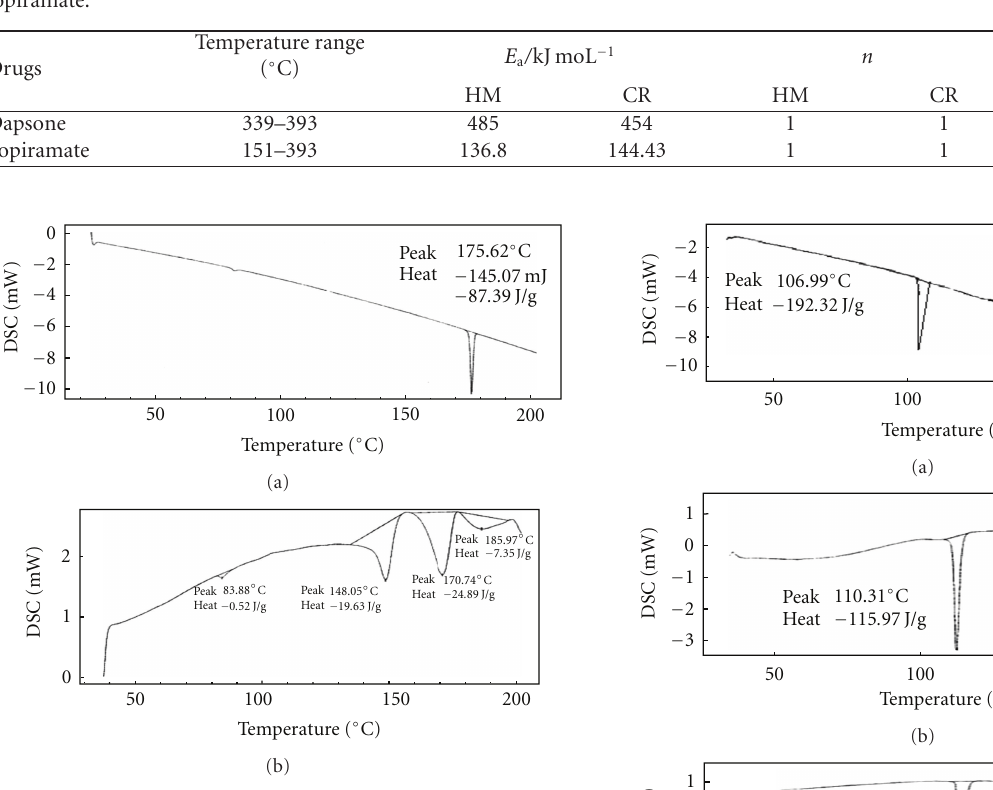
Table 3: Kinetic parameters obtained by the methods of Horowitz and Metzger (HM) and Coats and Redfern (CR) for Dapsone and Topiramate.